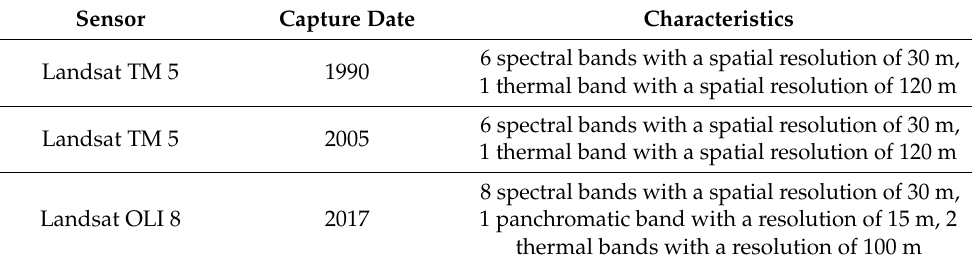
Table 1. Characteristics of the images used in the study. Sensor Capture Date